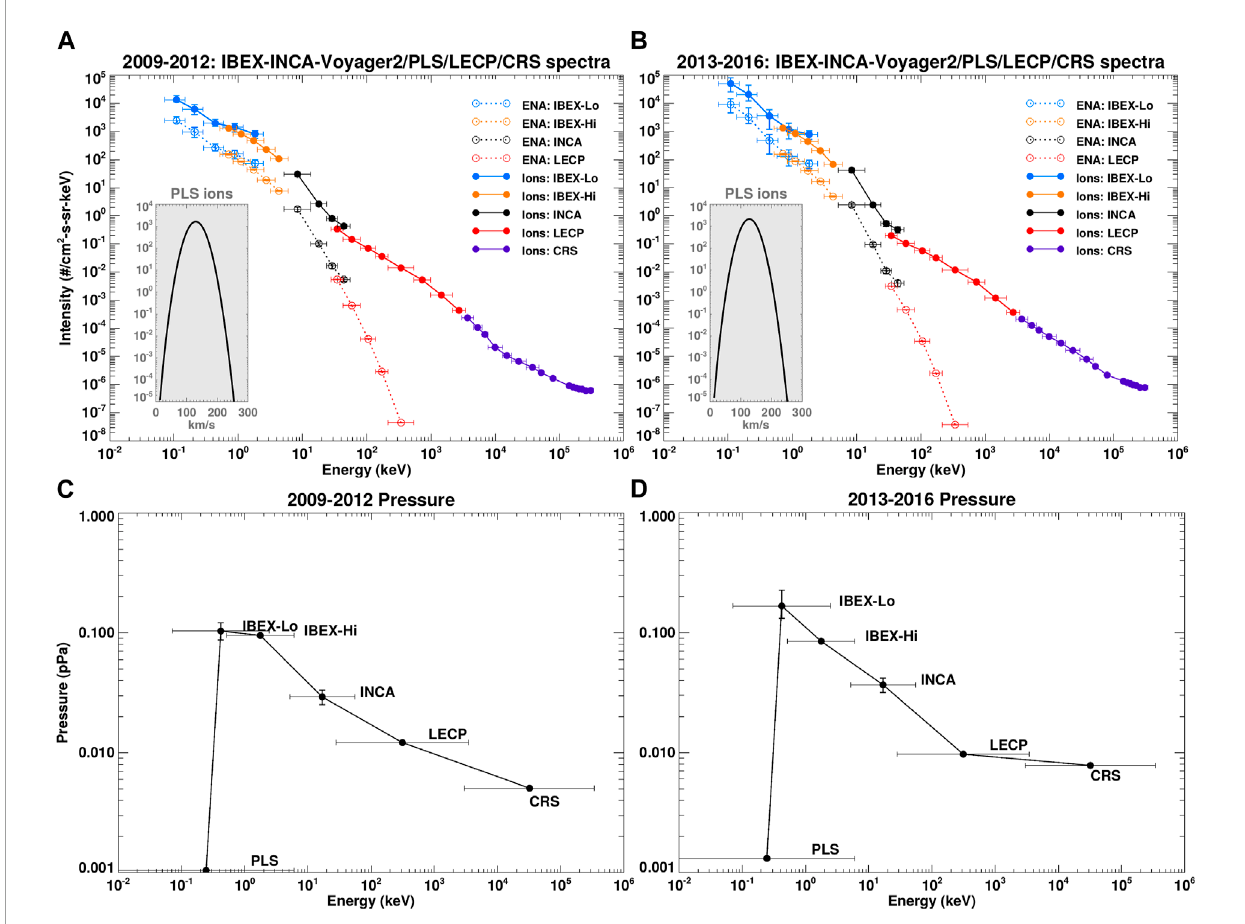
FIGURE 3 Average 0.11–55 keV ENA energy spectra (IBEX, INCA) in the pixels enclosing the position of V2, together with the deduced H + spectra (L HS = 35 AU and n H = 0.12 cm −3 ), and the 0.028–344 MeV ion energy spectra measured in-situ (LECP, CRS) for (A) 2009–2012 and (B) 2013–2016. The inlays indicate the 10 to 5,950 eV ion intensities derived from fits to the PLS data with an isotropic Maxwellian. The ∼ 28–540 keV LECP measurements are converted to ENAs, providing a prediction for the upcoming IMAP. If IMAP observed similar energy, this would indicate that these ENAs are the result of charge-exchange interactions inside the heliosheath. Possible differences would enable the search for different source and/or acceleration mechanisms (C, D) The average 10 eV to 344 MeV H + partial pressures inside the heliosheath, within the energy ranges covered by each different instrument (PLS, IBEX-Hi, IBEX-Lo, INCA, LECP and CRS) using the measurements in panels (A) and (B) (details in (Dialynas et al.,